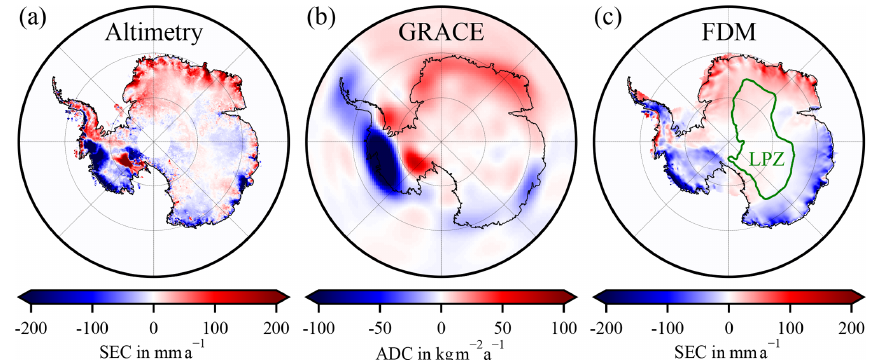
Figure 1. (a) Surface elevation change (SEC) from the multi-mission altimetry product (Schröder et al., 2019a), (b) GRACE-derived area density changes (ADC), and (c) FDM-derived SEC (time period: April 2002–August 2016). A Gaussian filter was applied to the GRACE result (half-response 250km). Low-precipitation zone (LPZ) (green, c